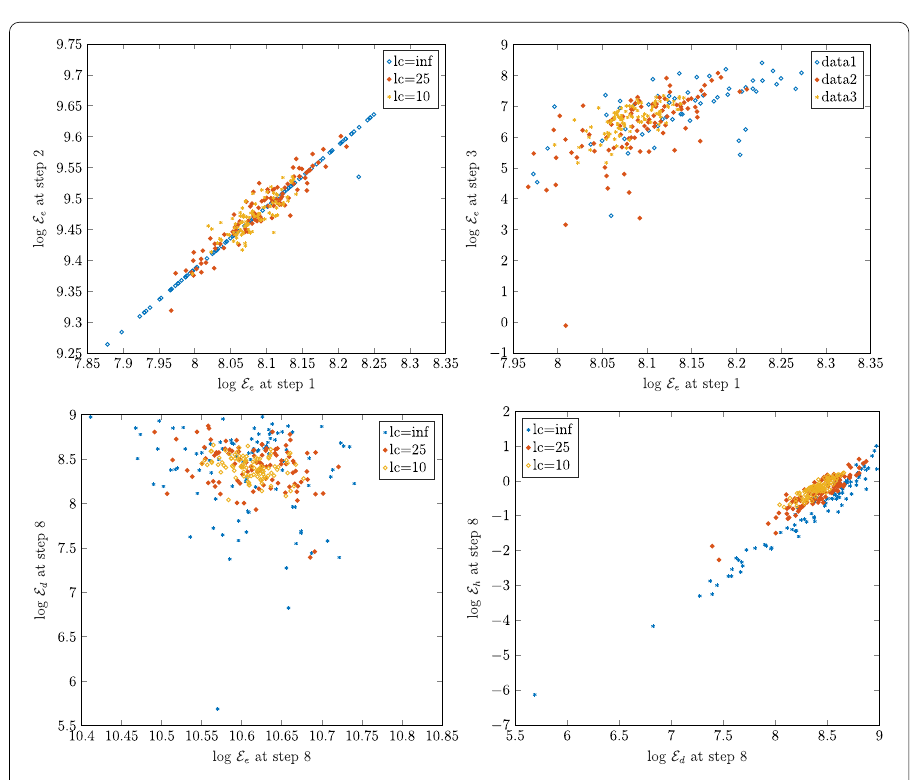
Fig. 16 Scatter plots of log of energies in [J]: E e and E d w.r.t. to different time steps